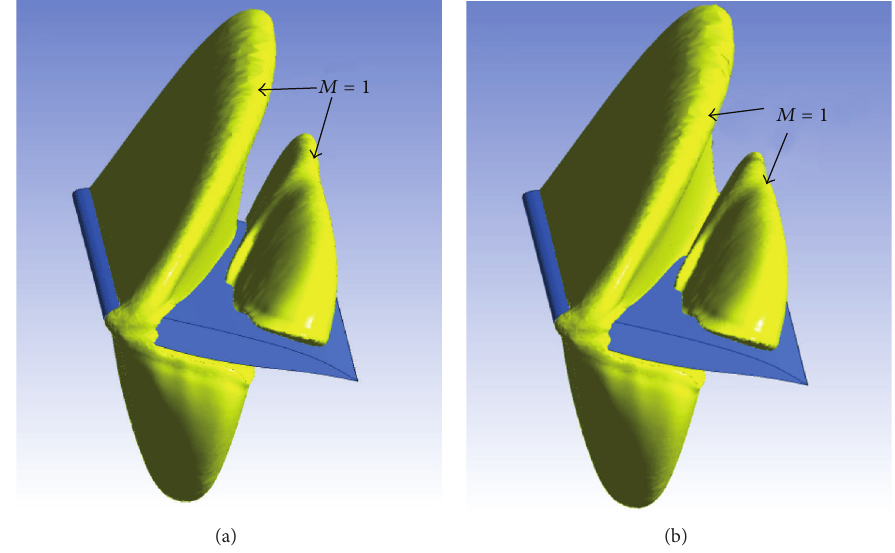
Figure 4: Sonic surfaces on the J-78 unswept wing at 𝛼 = − 0.6 deg, Re = 5.2 × 10 6 . (a) 𝑀 ∞ = 0.8635 ; (b) 𝑀 ∞ = 0.8640 .